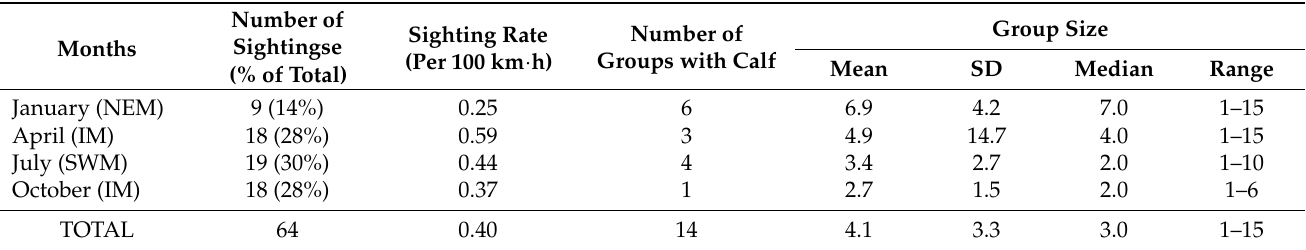
Table 2. The group size of Irrawaddy dolphins and the number of calves sighted during the sampling years of 2016 to 2018.